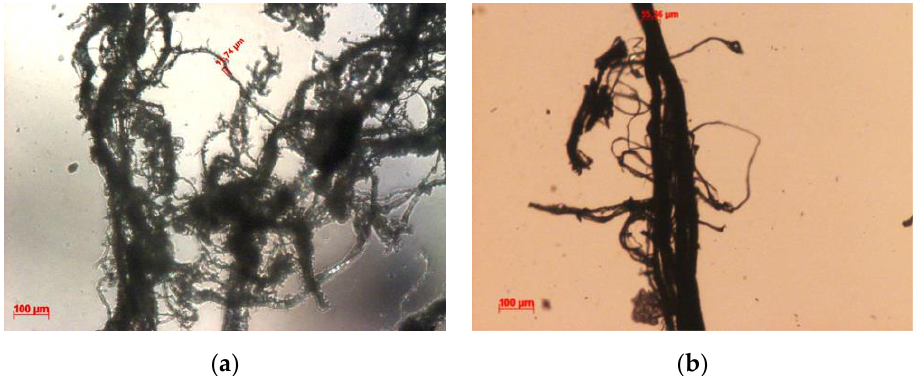
Figure 4. Physical aspect of: ( a ) wet blue; ( b ) finished leather scraps, before and after grinding.